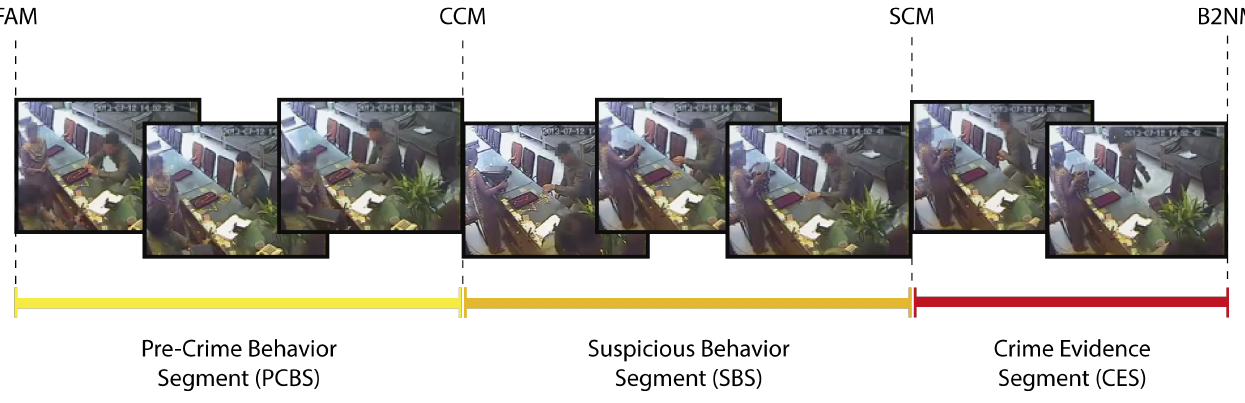
Figure 2. Video segmentation by using the moments obtained from the Pre-Crime Behavior Segment (PCB)